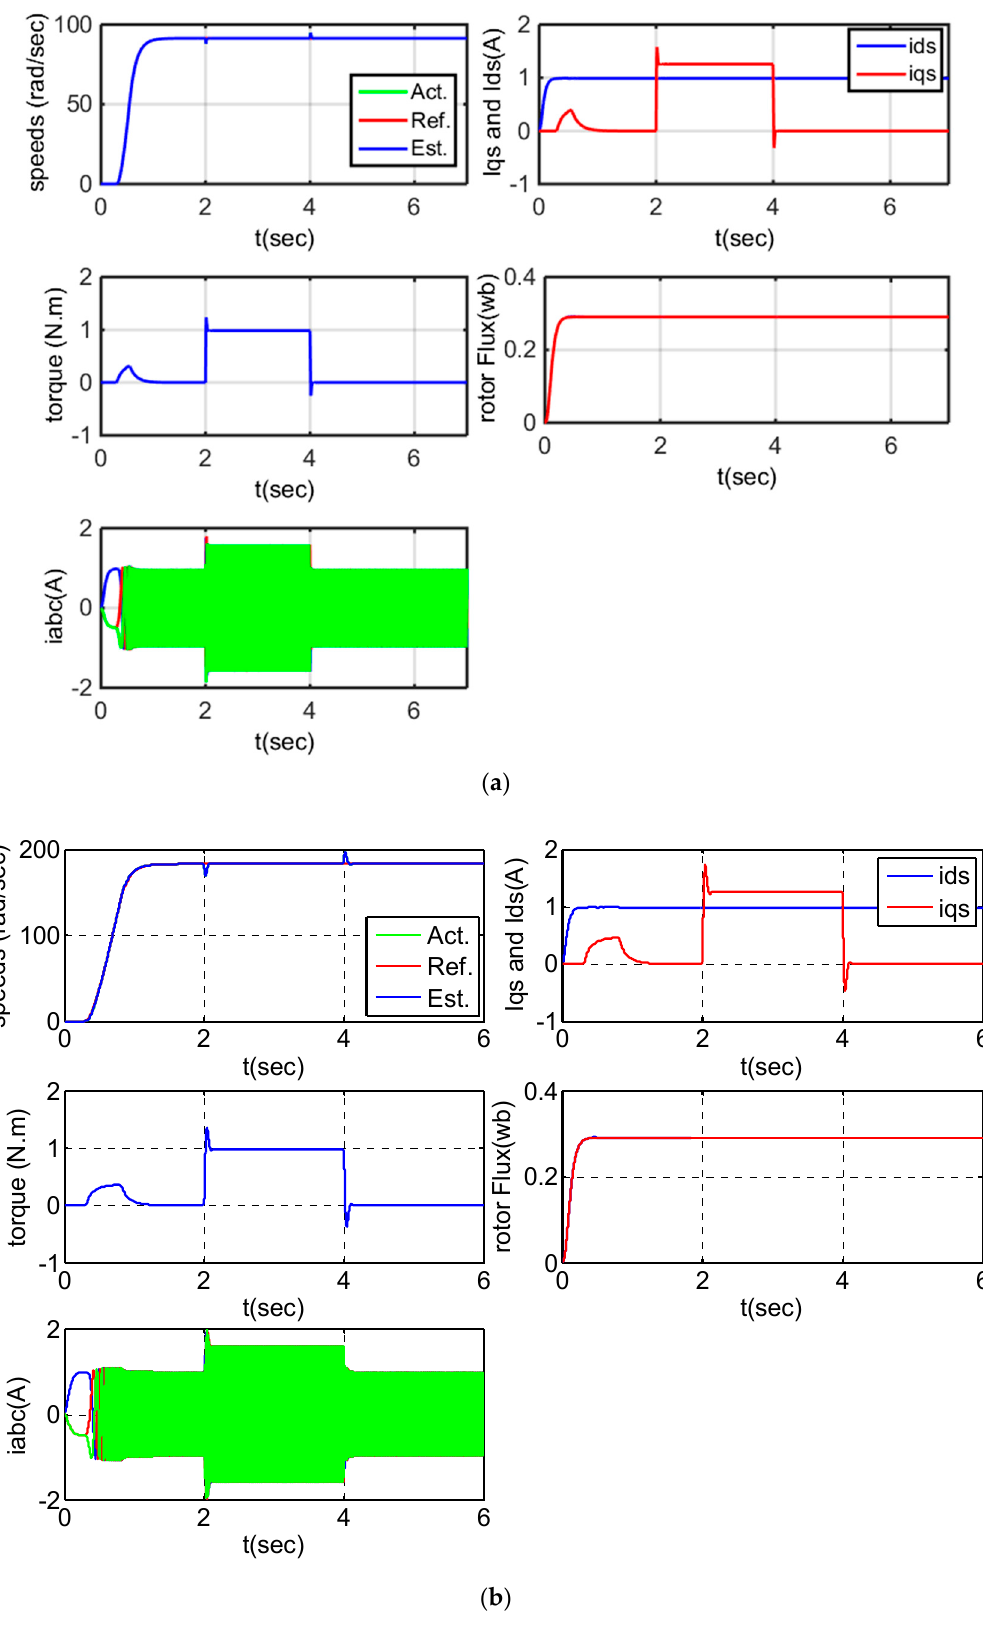
Figure 9. Simulation results of speed transient with load step changes of rated values using the proposed sensorless drive system; ( a ) with H ∞ controller and ( b ) with PI controller.